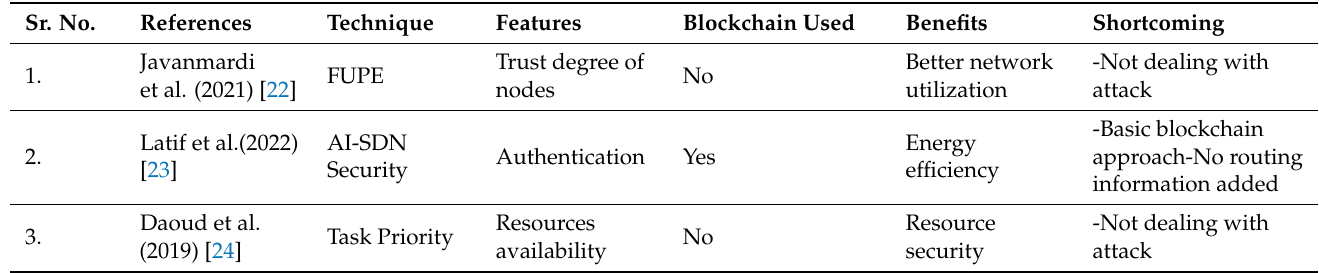
Table 1. A brief comparison of the existing